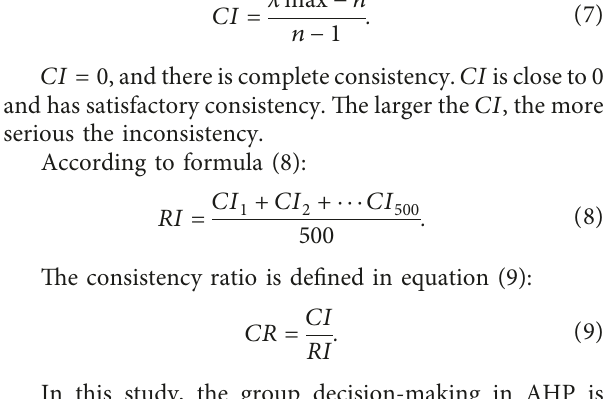
Figure 9: Functional diagram of strategic control mechanism. Table 2: Scaling method for judgment matrix element b Scale